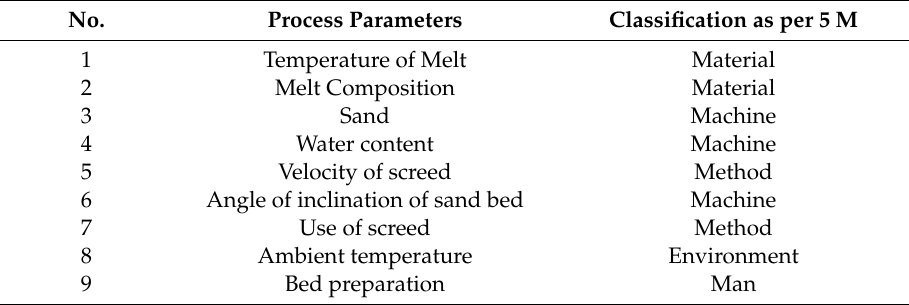
Table 2. Factors potentially a ff ecting the quality of cast sheets.